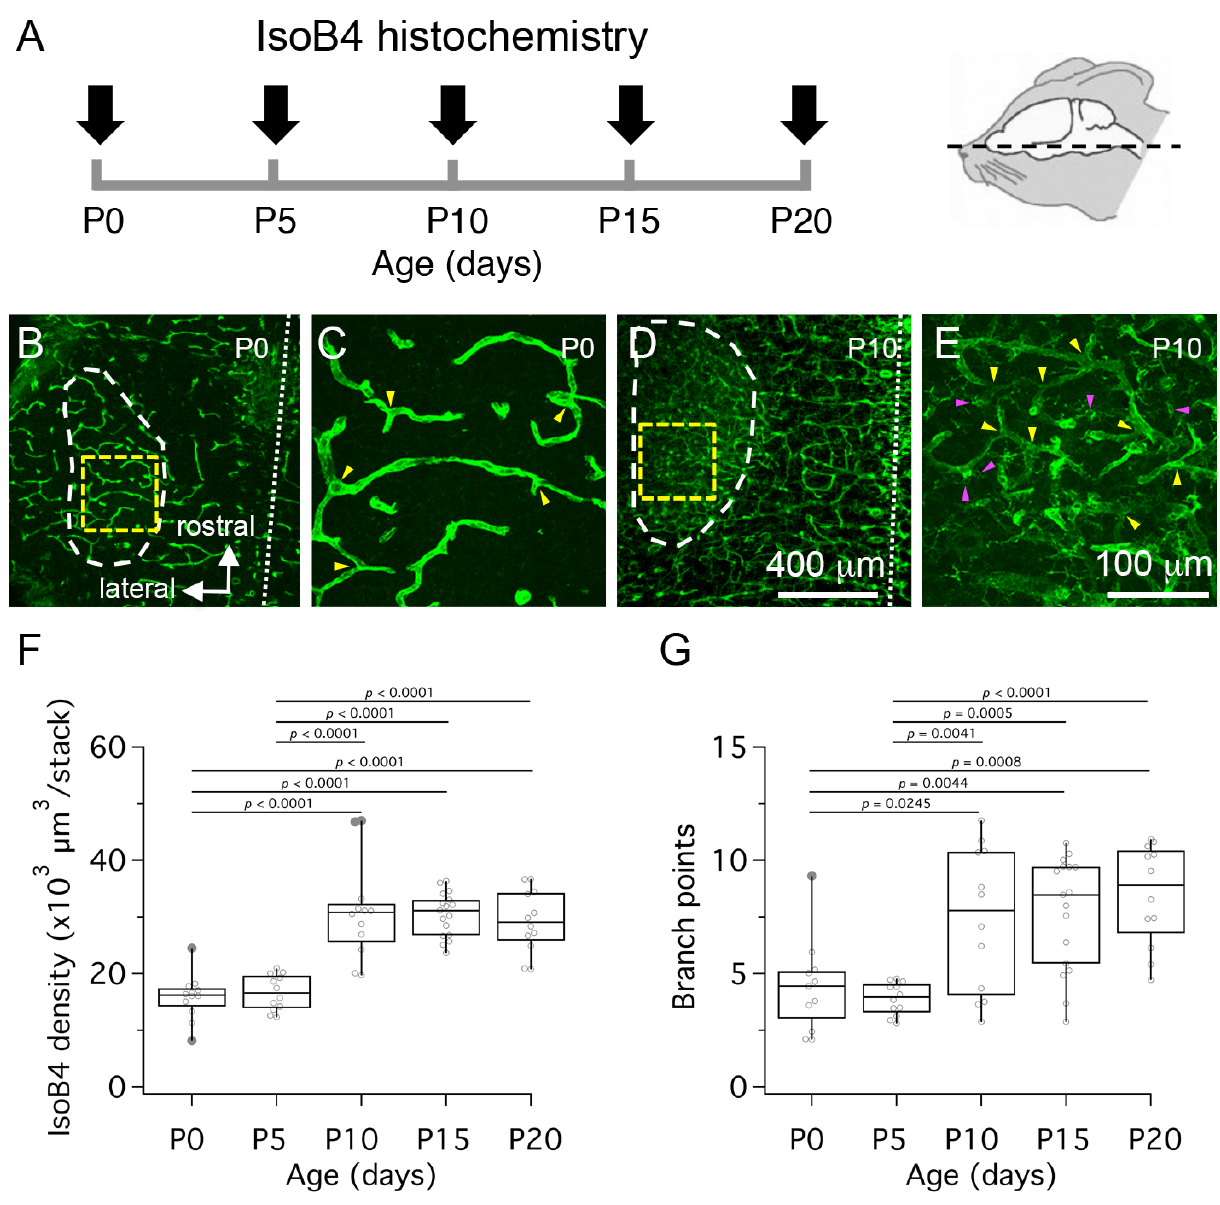
Figure 2. Postnatal development of the medial nucleus of the trapezoid body (MNTB) vascular bed. ( A ) To visualize the MNTB vascular bed, horizontal tissue sections from rat pups were processed for isolectin-B4 (IsoB4) histochemistry at different ages as indicated by black arrows. ( B ) Low magnification confocal z-projection view shows the MNTB outline (white dashed line) in a P0 brainstem slice stained with IsoB4 histochemistry. ( C ) High magnification confocal z-projection view of IsoB4 labeled blood vessels in the MNTB of a P0 brainstem slice. ( D ) Low magnification confocal z-projection view shows the MNTB outline (white dashed line) in a P10 brainstem slice stained with IsoB4 histochemistry. ( E ) High magnification view of IsoB4 labeled blood vessels in the MNTB of a P10 brainstem slice. ( F ) Quantification of IsoB4 fluorescence density at different ages. ( G ) Quantification of vascular branch points at different ages. Yellow dashed squares in panels ( B , D ) represent regions of interest examined at high magnification in panels C and E. White dotted lines in ( B , D ) represent the midline. Yellow arrowheads in ( C , E ) indicate vascular branch points. Magenta arrowheads in E indicate cellular profiles labeled with IsoB4 histochemistry. Scale bar in ( D ) applies to ( B ). Scale bar in ( E ) applies to ( C ). P values are corrected for multiple comparisons. Only statistically significant p values are printed.